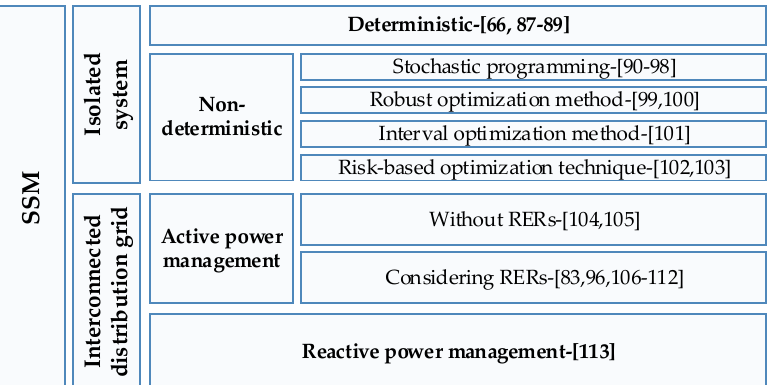
Figure 3. Categories of SSM schemes.